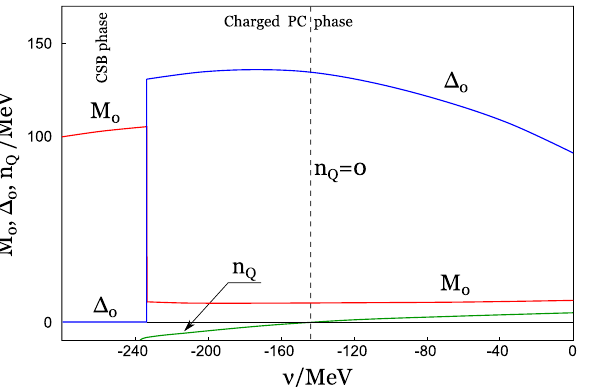
Fig. 14 The condensates (cid:4) 0 , M 0 and electric charge density n Q as a function of ν in the ground state of β -equilibrium quark matter at μ = ν = 5 . 5 = 400 MeV and μ = 300 MeV in the chiral limit, m = 0. At 0 0 5 5 ν < ν ≈ − 240 MeV the condensates correspond to the CSB phase. At c ν > ν β -equilibrium quark matter is realized. c the charged PC phase of Note that at the point ν 0 ≈ − 140 MeV we have n Q = 0. It means that at ν = ν β -equilibrium quark matter is electrically neutral and there 0 the the charged PC phase is